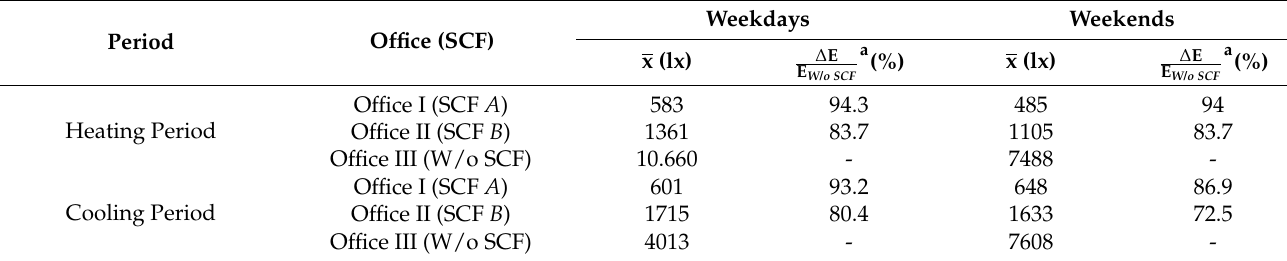
Table 3. Experimental results of the visible performance ( E i , v ) of the offices based on data of working hours (between 9 a.m. and 6 p.m.) from days when the VRV unit was turned on (weekdays) and off (weekends) in the heating and cooling periods.